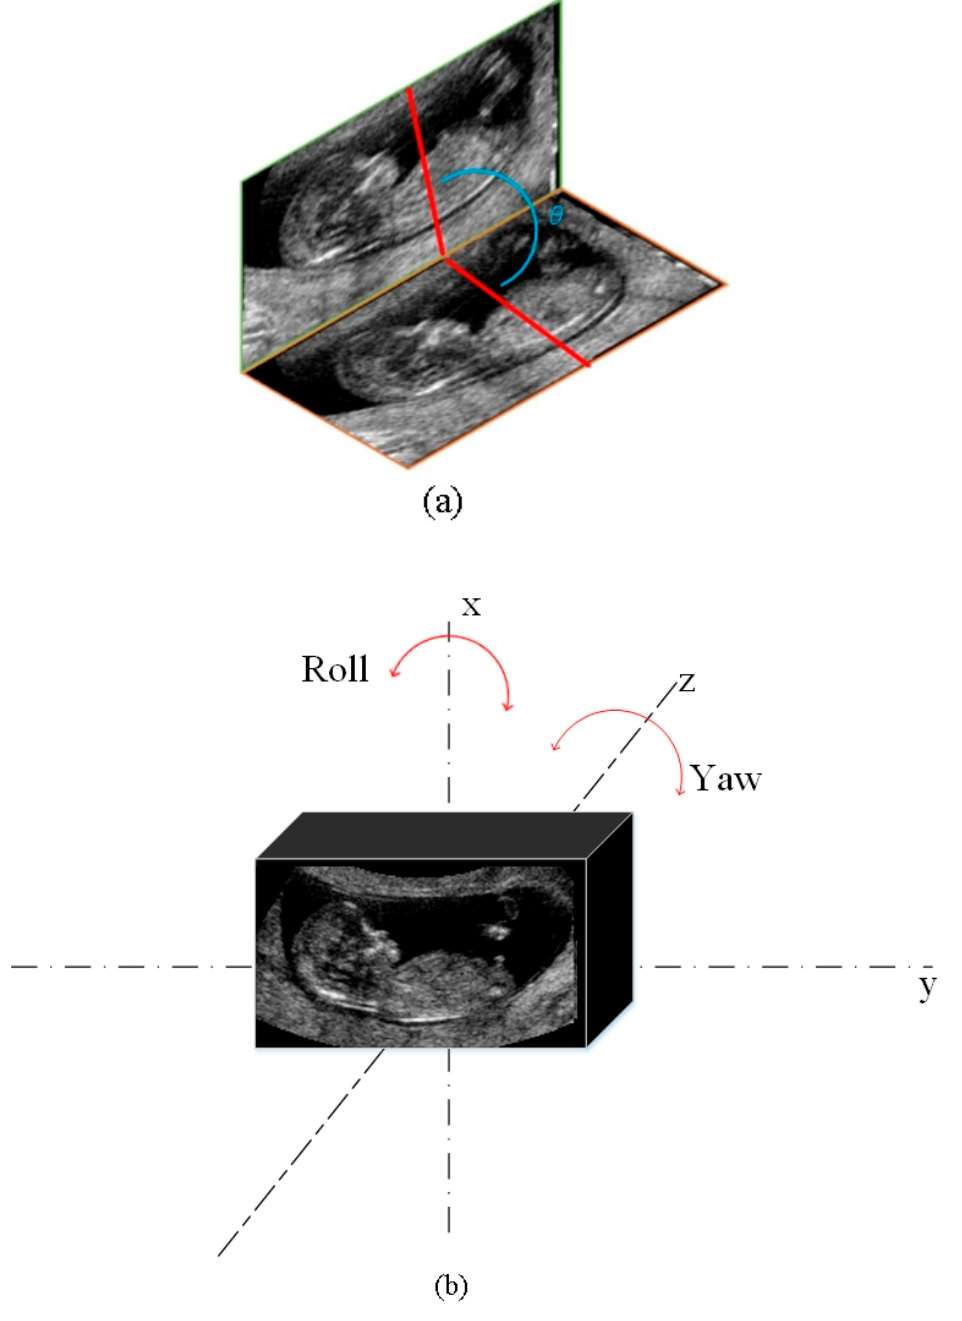
Figure 9. Metrics to evaluate the performance of the proposed network. ( a ) The included angle θ is the angle between the automatically detected and manually extracted MSPs. ( b ) The roll and yaw angles indicate the rotation of the detected MSP with respect to the x- and z-axes, respectively.